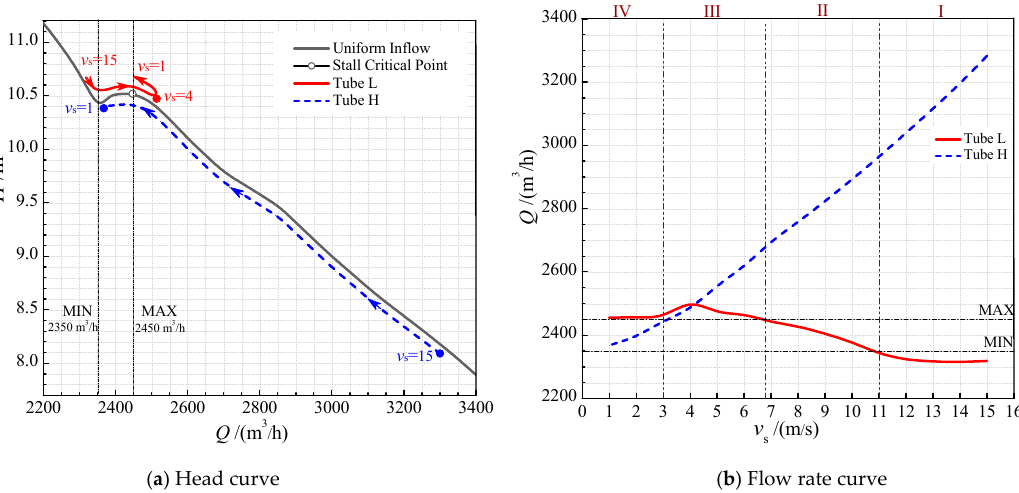
Figure 7. Variations of head and flow rate of each tube in parallel waterjet pump system within the ship speed range from 1 m/s to 15m/s.